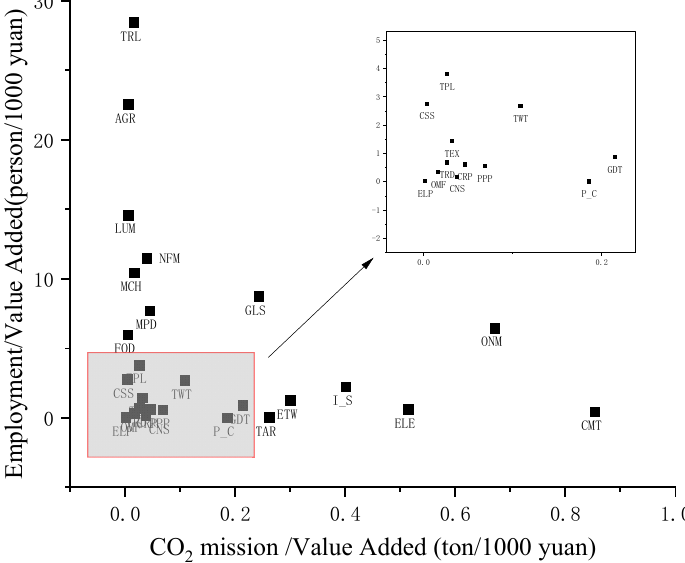
Figure 12. Cluster analysis of value added, carbon emissions and employment in ES scenario.